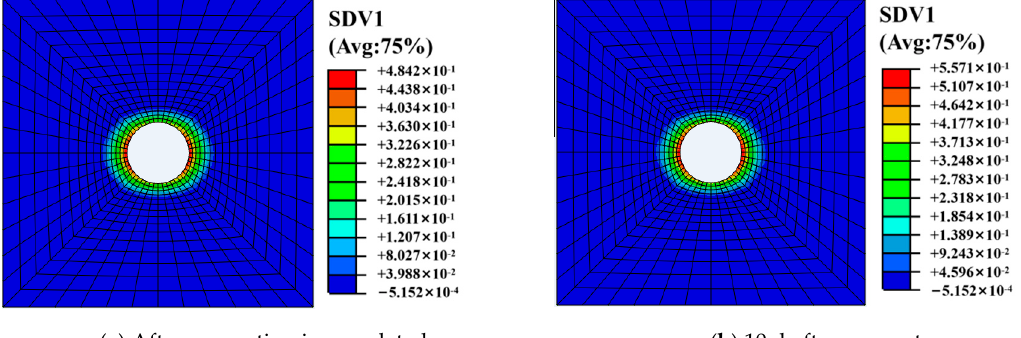
Distance (m) AB EF CD Figure 7. Variation curve of pore pressure at different positions of roadway. (2) Damage Zone Development Figures 8 and 9 show the distribution of the surrounding rock damage zone at different times. It can be seen from the Figure 9 that the surrounding rock is damaged after the roadway excavation. The damage value is 0.3–0.5. The damage degree of the surrounding rock gradually increases with